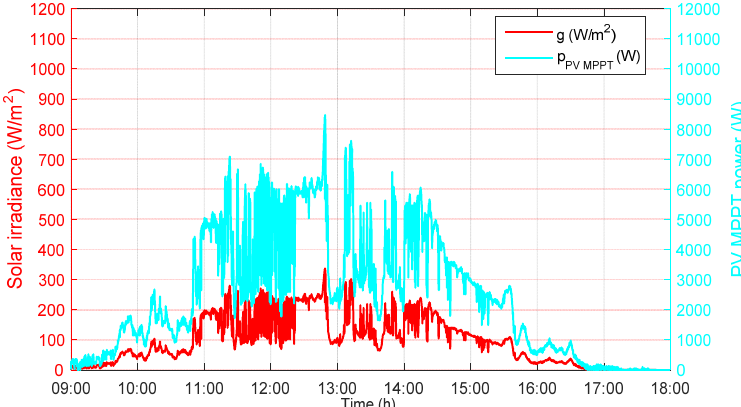
Figure 14. Solar irradiation and PV MPPT power—Case 2.